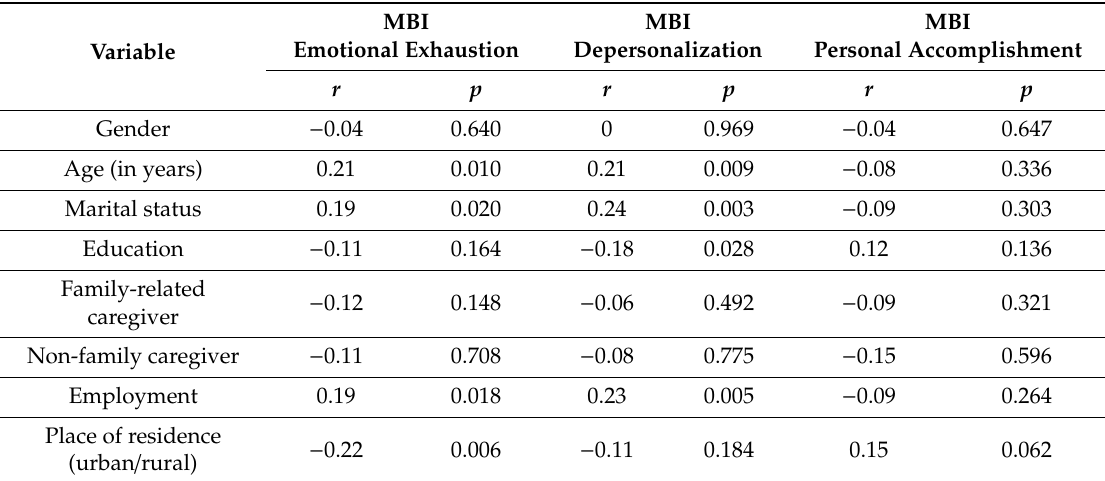
Table4. The relationship between variable sociodemographic data and the levelof emotional exhaustion, depersonalization, and personal accomplishment among caregivers.